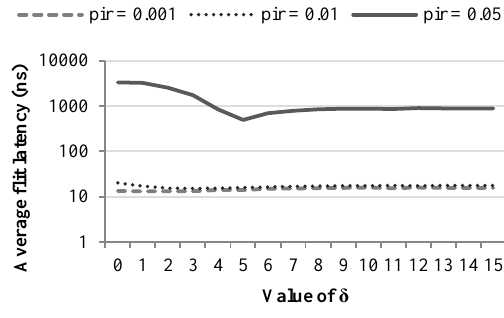
Figure 6. Effect of δ on the average flit delay for different values of PIR (8 wireless